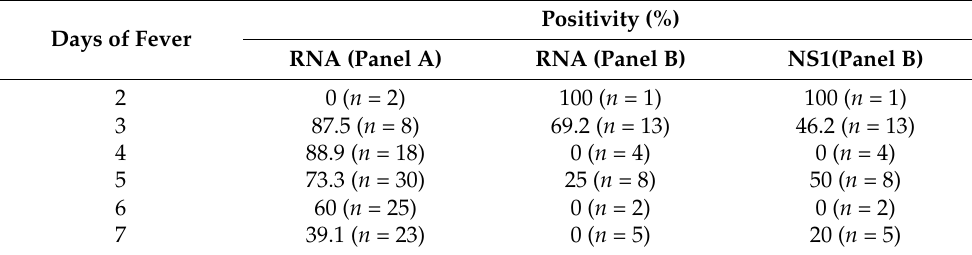
Table 1. Comparative analysis of positivity of DENV RNA from Panels A and B, and NS1 in saliva collected from Panel B patients according to the days of